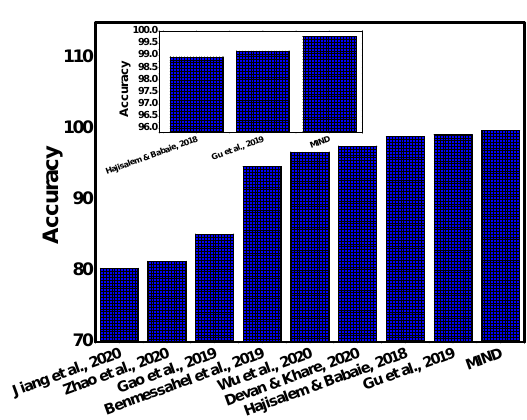
( b ) Comparison of Detection Rate with Existing Studies